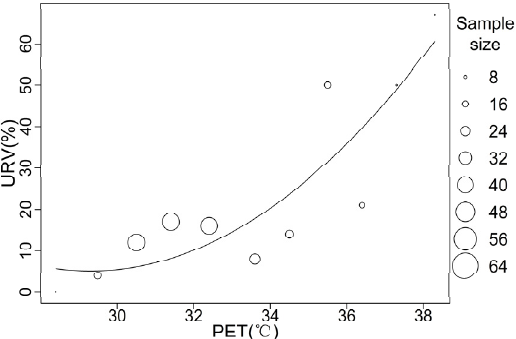
Figure 7. Correlation between URV and PET of the elderly in summer.